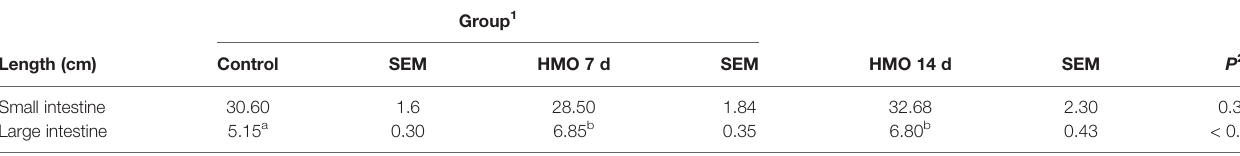
For each group, the average length is presented along with the standard error of the mean (SEM). 1 Groups: Control=germ-freemice euthanizedat50daysofage(n=5;M=3,F=2);HMO7 d=germ-free micethatreceived 100µlofHMO(15mg/day)through 7consecutivedays